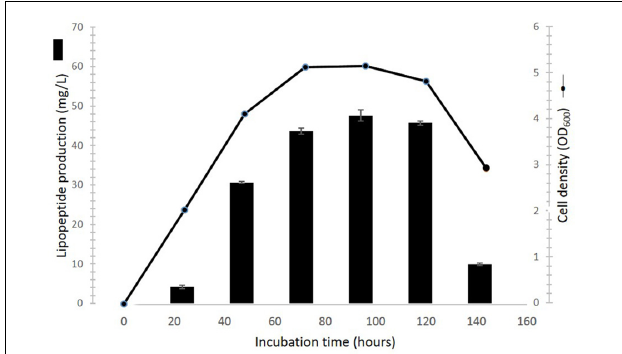
FIGURE 7 | Time course of cell growth and lipopeptides production of Pseudomonas sp. UCMA 17988 in glucose-MSM medium. Cell growth was evaluated by optical density measurement at 600 nm. Lipopeptide was quantified by HPLC.